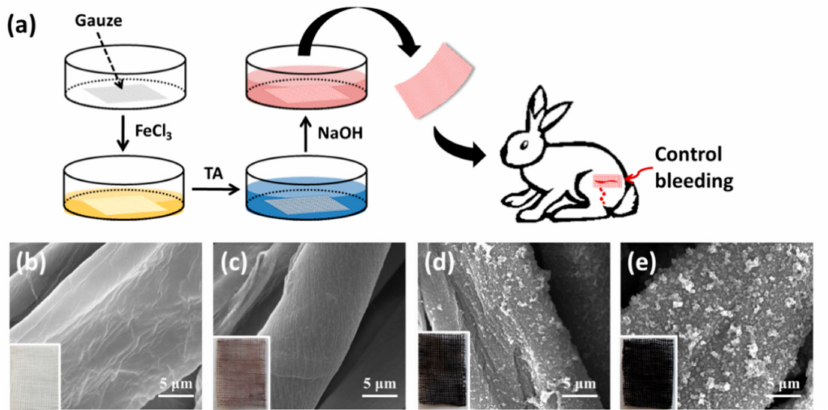
Figure 3. ( a ) Schematic illustration of the preparation of the TA-coated gauze and its application in bleeding control. SEM images of the gauze ( b ) and TA-coatedgauzes with one ( c ), three ( d ) and five ( e ) TA deposition cycles. Bar = 5 µ m. Insets are the corresponding digital